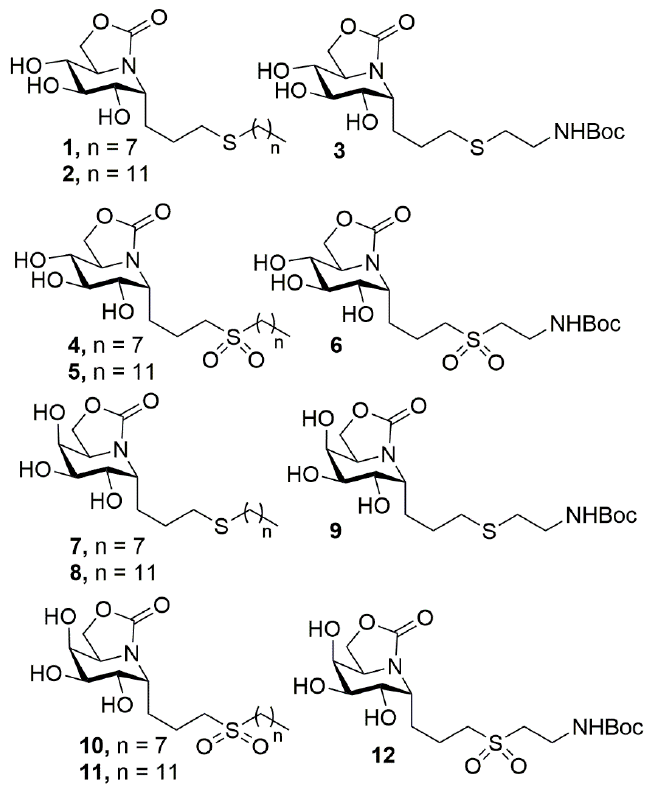
Figure 2. Chemical structures of the pseudo- α - C -glycoside sp 2 -IGLs prepared in this work.